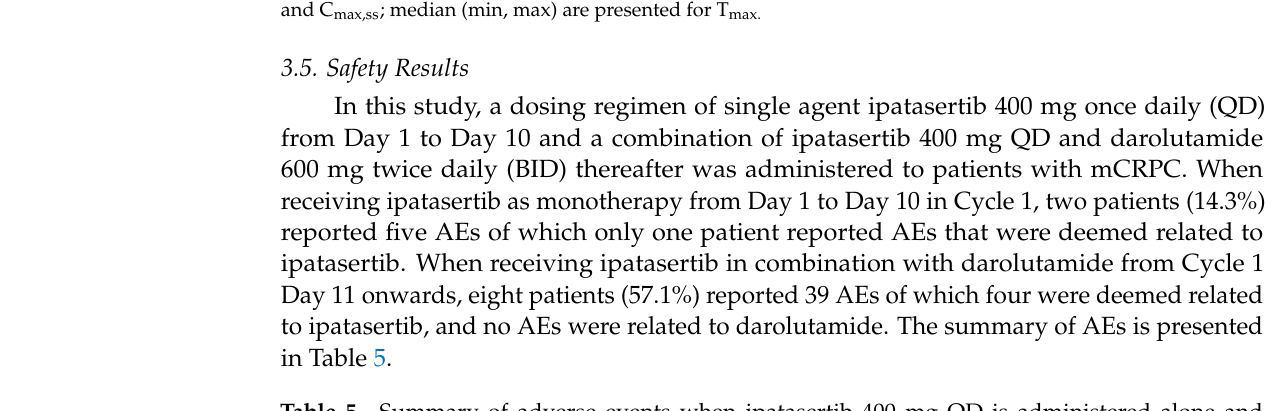
Table 5. Summary of adverse events when ipatasertib 400 mg QD is administered alone and ipatasertib 400 mg QD is administered in combination with darolutamide 600 mg